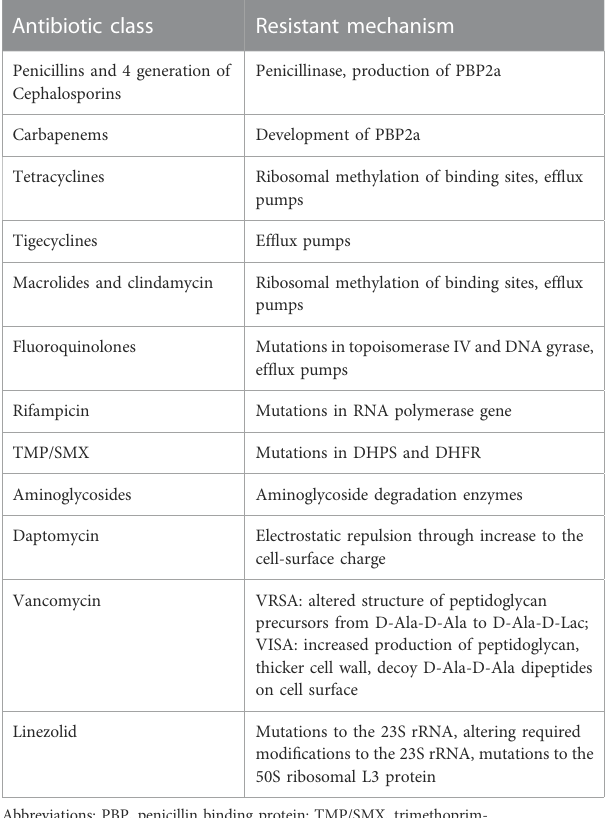
TABLE 2 Summary of antibiotic resistant mechanisms in